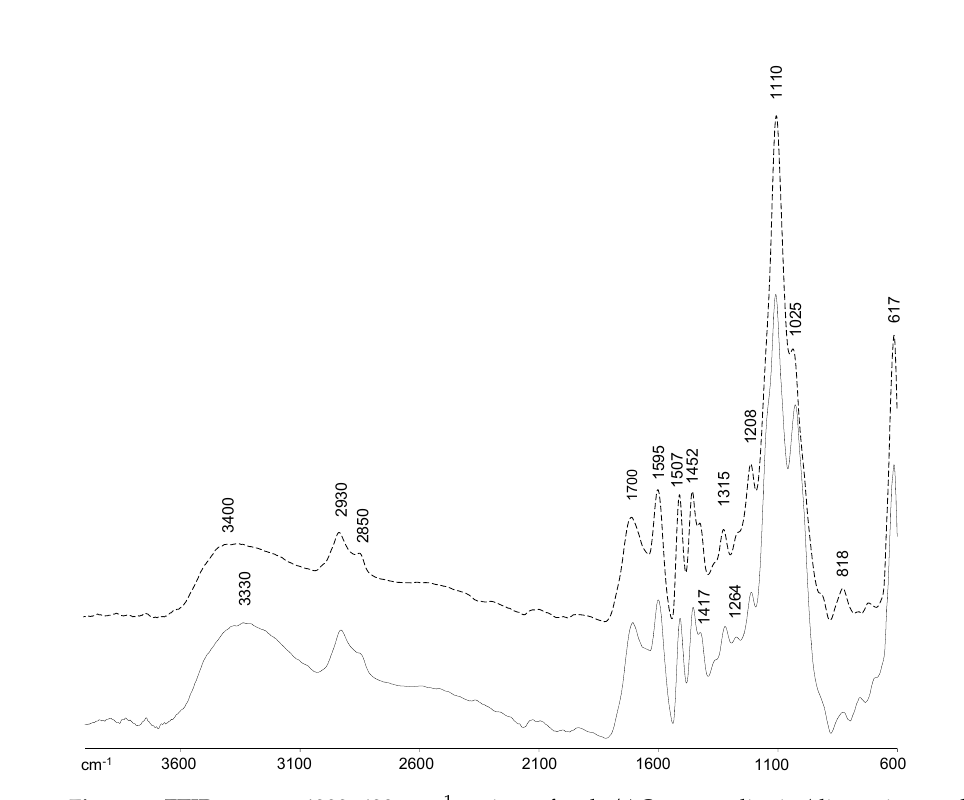
Figure 1. FTIR spectra, 4000–600 cm − 1 region, of soda/AQ-orange lignin (discontinuous line) and soda/AQ-olive lignin (continuous line).